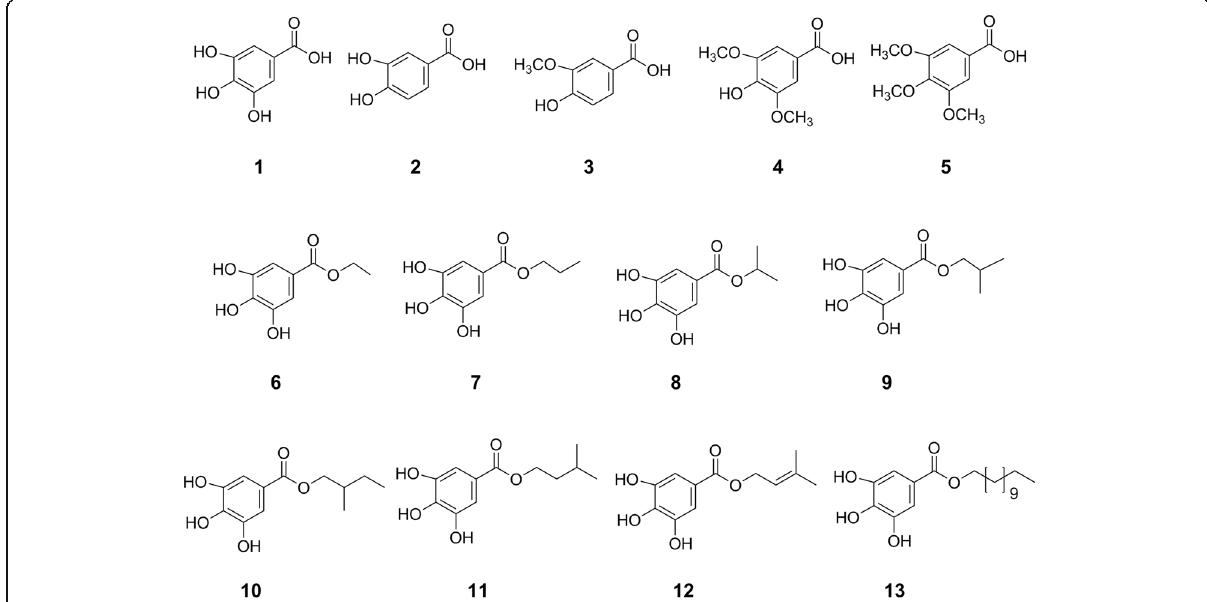
Fig. 1 Chemical structure of gallic acid derivatives isolated from C. gabunensis , synthetic and commercially available gallate derivatives used in this